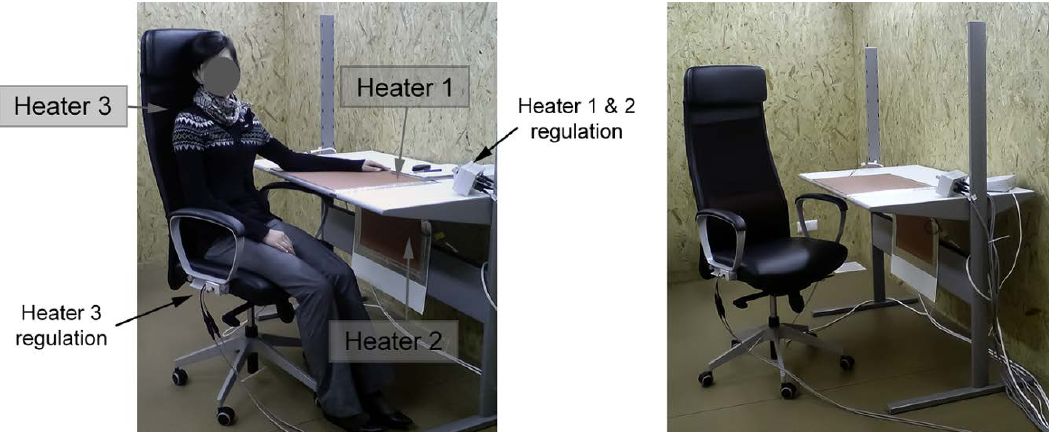
Figure 1. Workstation incorporating three heating mats (heaters).